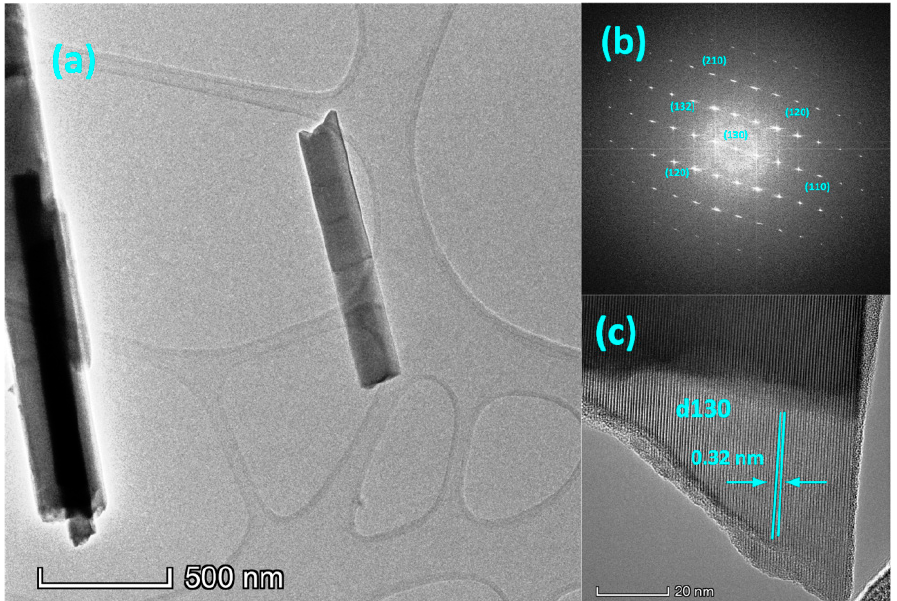
Figure 4. ( a ) TEM images of the Sb 2 S 3 NCs. ( b ) Selective area electron diffraction (SAED). ( c ) High-resolution (HRTEM) image of the fabricated Sb 2 S 3 NCs.